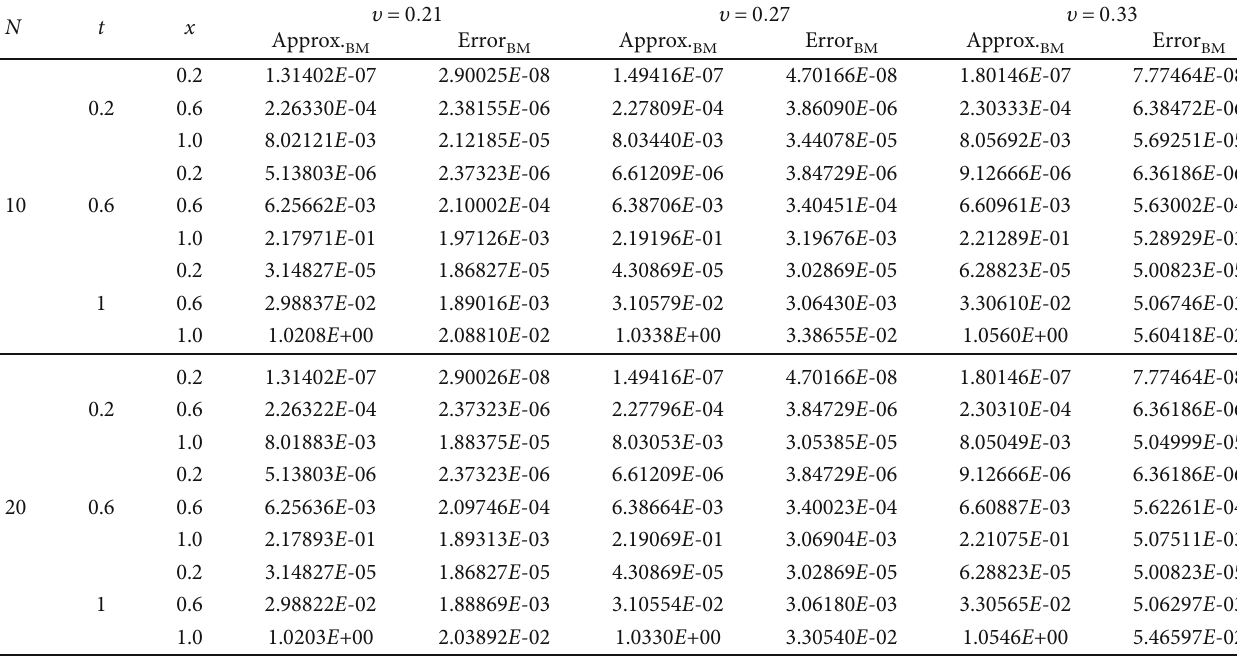
Table 1: The approximate values and the absolute relative error values using B-by-BM for linear case ( k = 1 ).